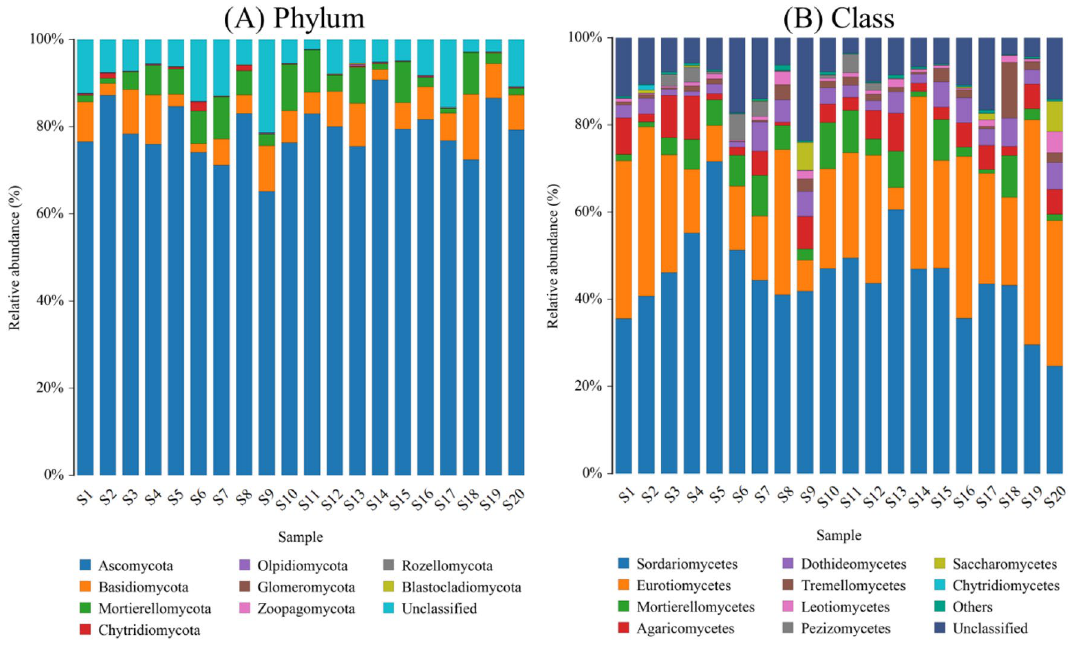
Figure 3. Relative abundance of dominant phyla ( A ) and classes ( B ) of fungi in the